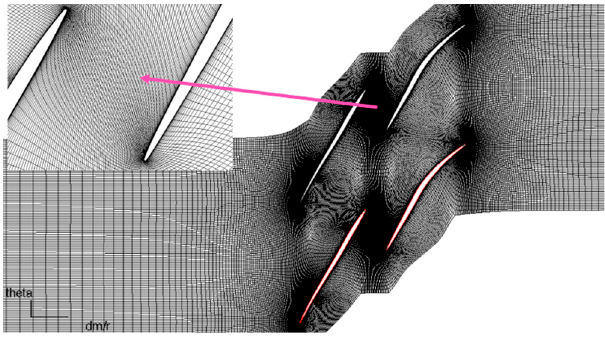
Figure 2. Tandem blade CFD (computational fluid dynamics) mesh. Table 4. The aerodynamic parameters simulated with different number of grids. Case1 Case2 Case3 Case4